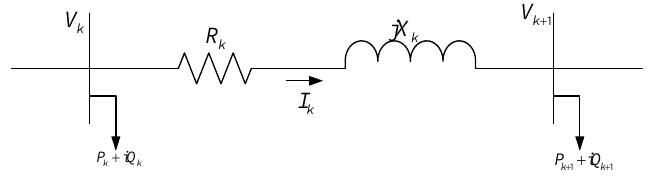
Figure 3. One-line diagram of a distribution framework for successive buses.